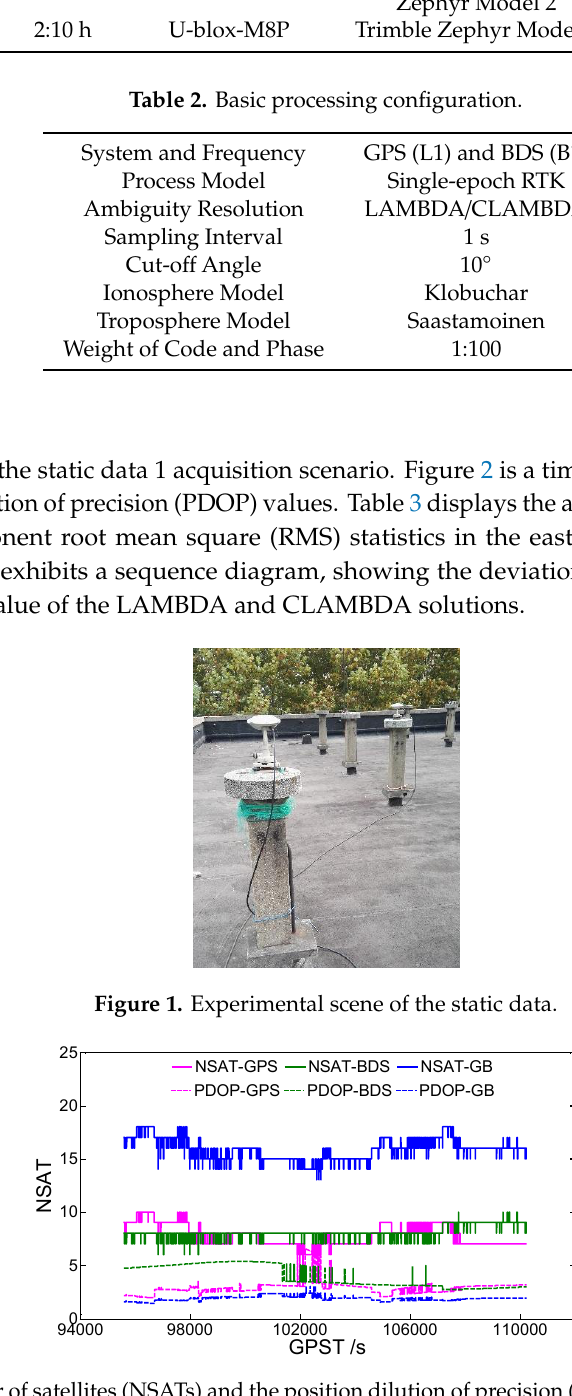
Figure 2. Number of satellites (NSATs) and the position dilution of precision (PDOP) value. GB denotes GPS + BDS.